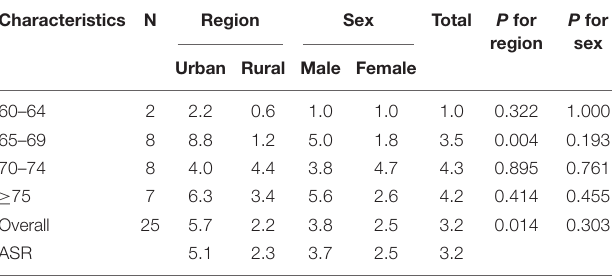
TABLE 2 | Prevalence of atrial fibrillation